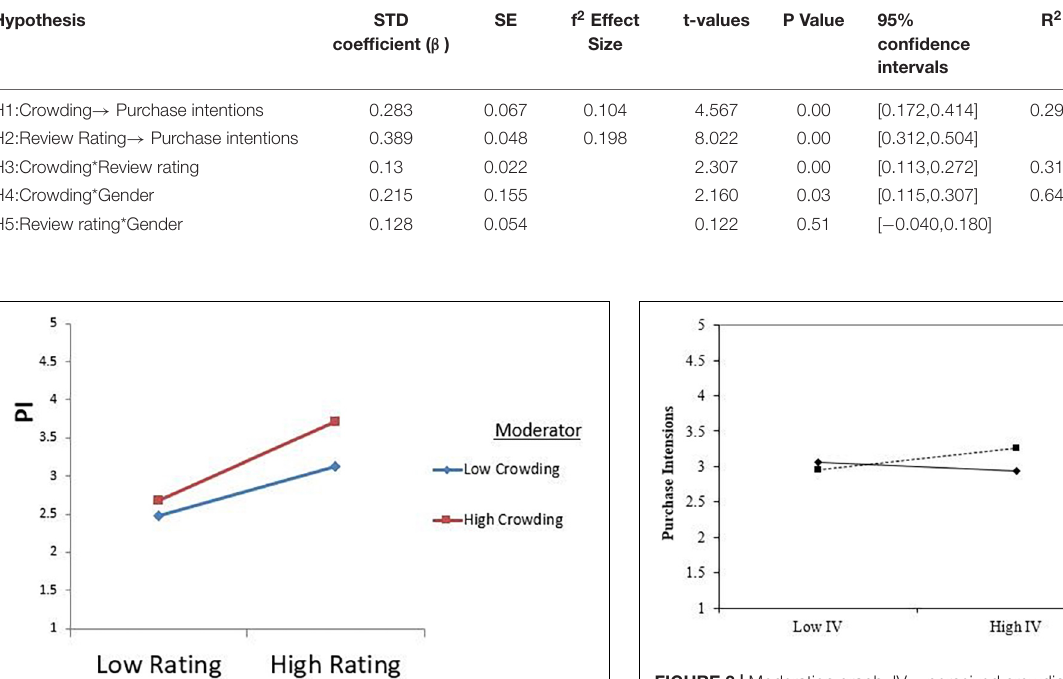
FIGURE 3 | Moderation graph: IV = perceived